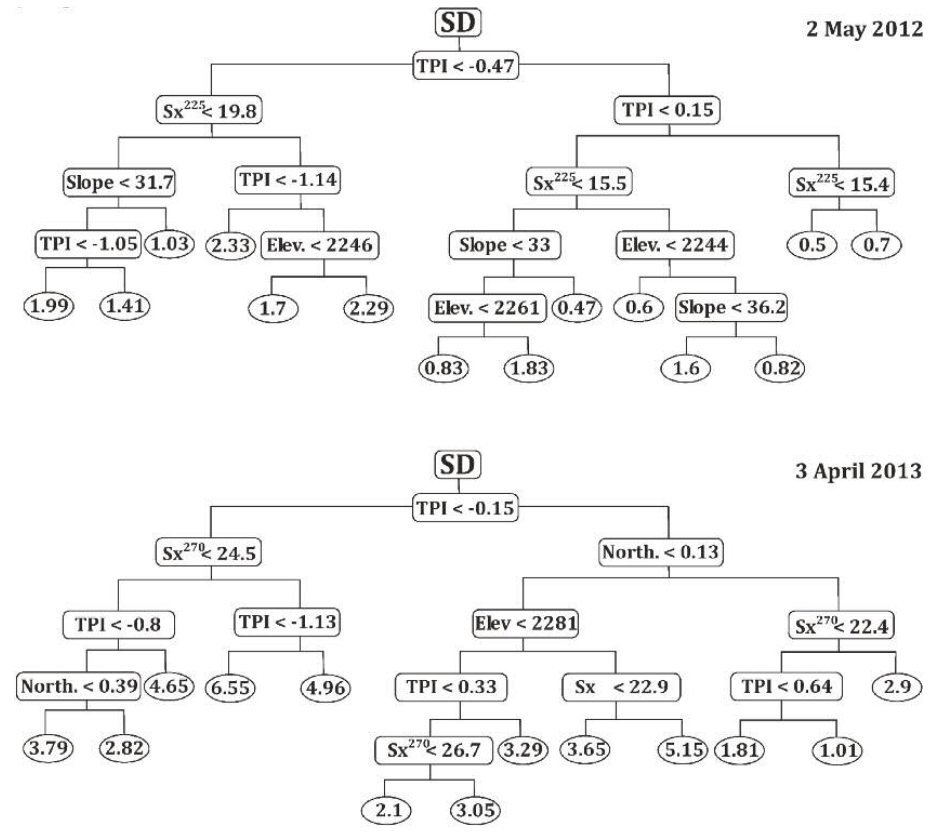
Figure 6. Binary regression tree obtained for 2 May 2012 (top) and 3 April 2013 (bottom). The final nodes (with ellipses) show the predicted SD in the zone having the specified terrain characteristics. At each branch point, one topographic variable is considered; if the value is less than the specified value, the left branch is selected, but if it is equal to or greater than the specified value, the right branch is selected.